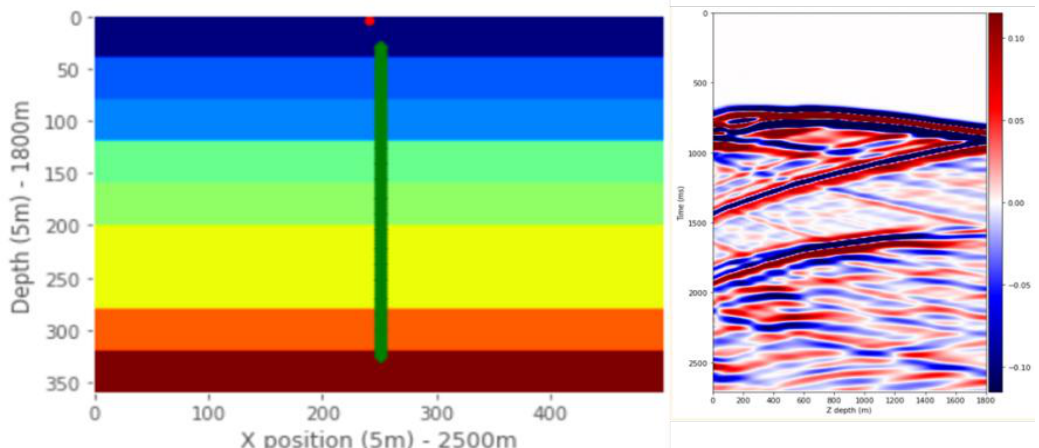
Figure 6—Single source zero offset VSP for single hydrophone receiver forward modeling